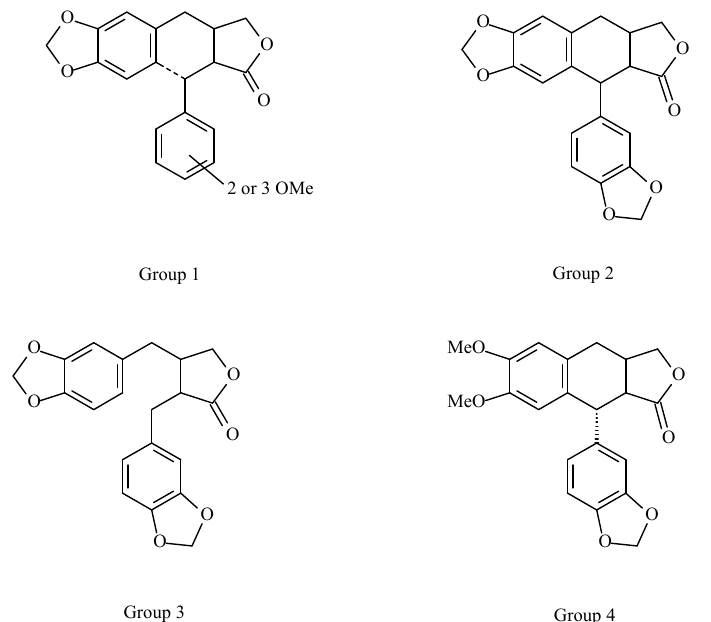
Figure 8. Groups of lignans present in Bursera spp. leaves according to Koulman [36].